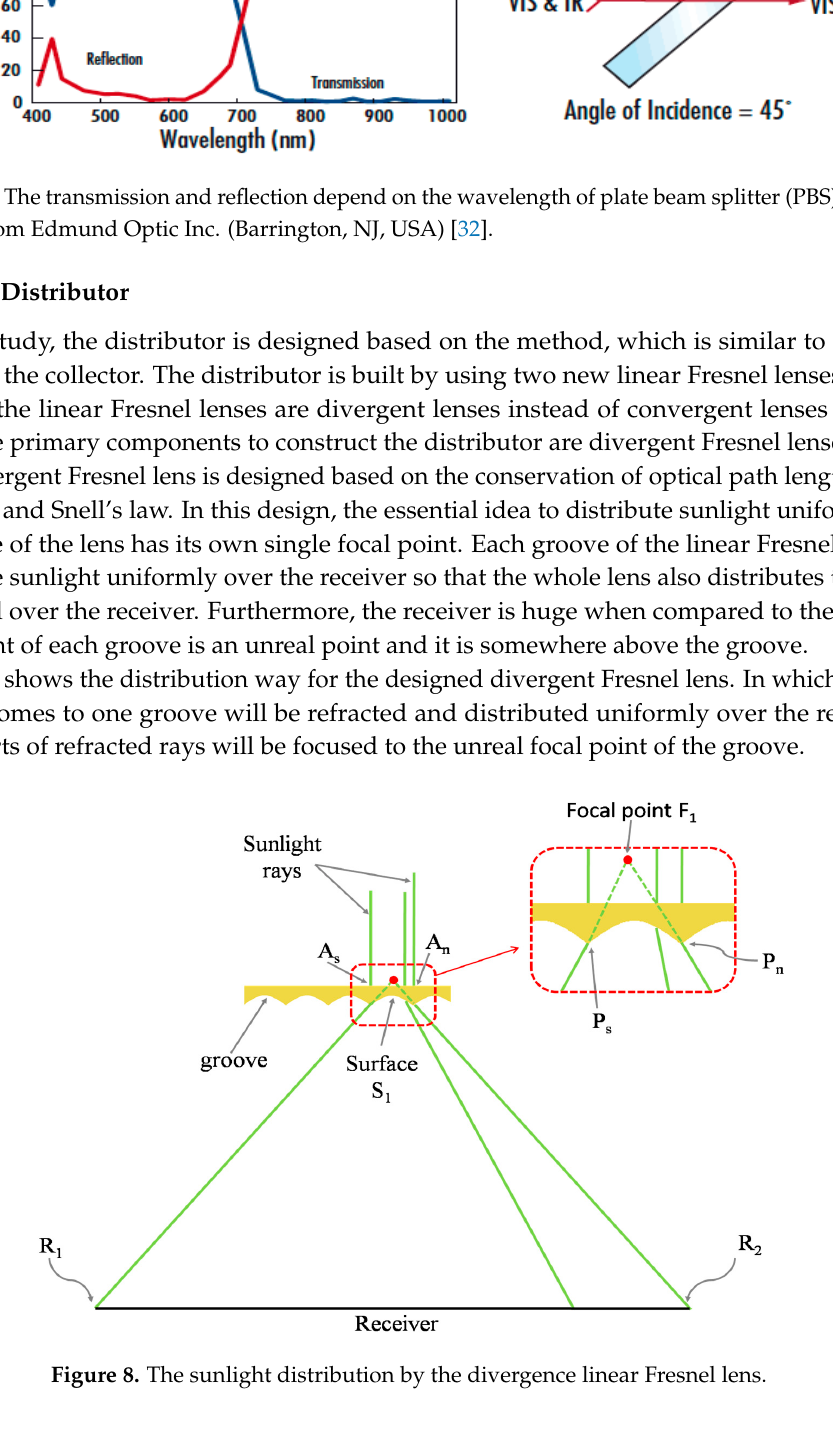
the sunlight. Furthermore, the heating problem can be solved in deeper way by using the plate beam